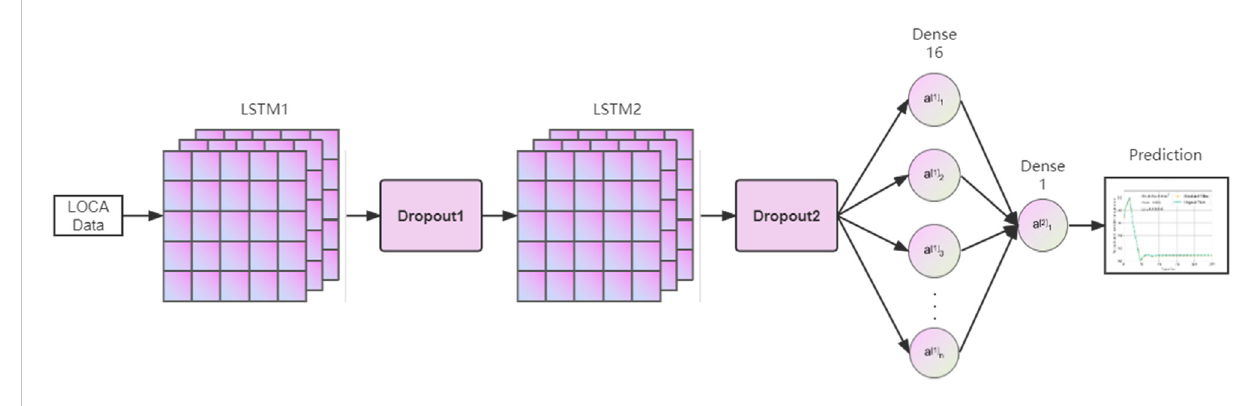
FIGURE 1 LSTM structure.